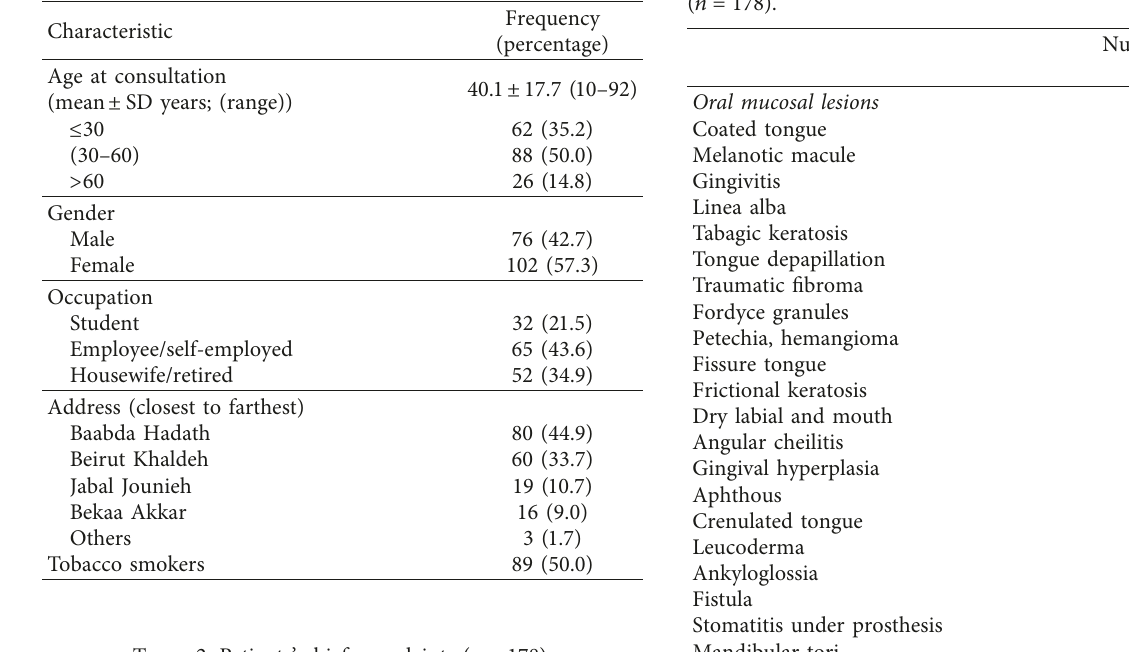
Table 2: Patients’ chief complaints ( n � 178).